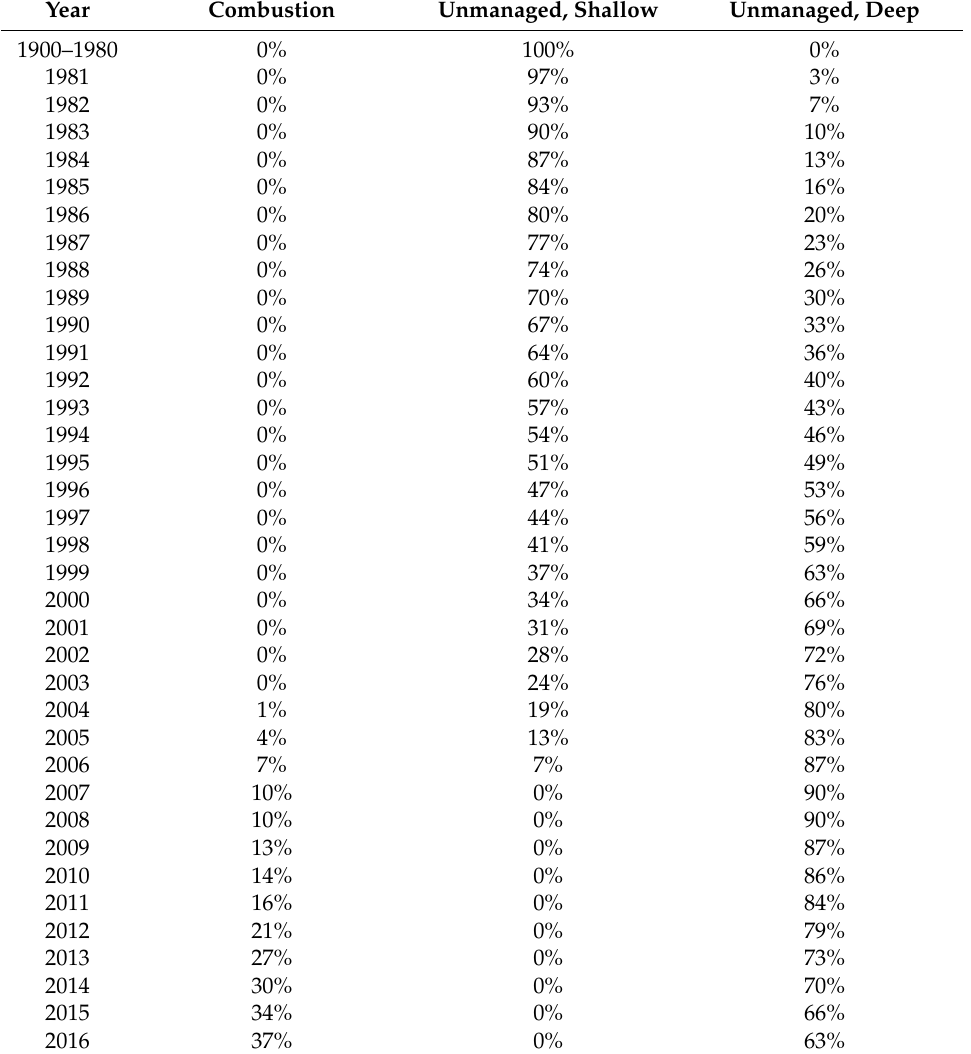
Table 2. Different disposal options of waste HWP after